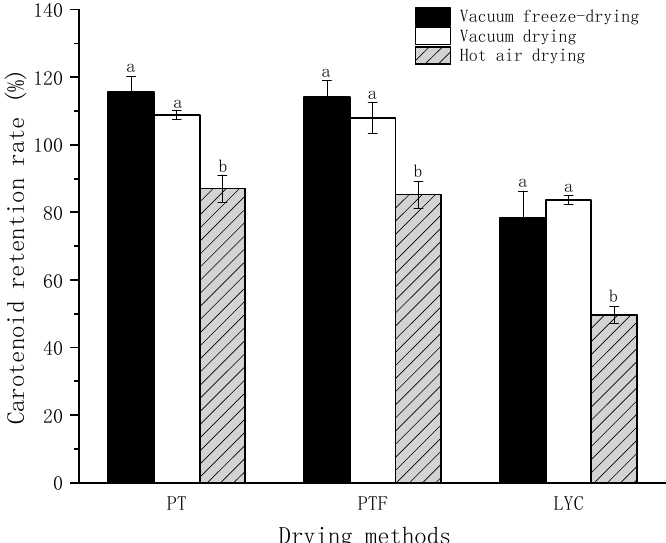
Figure 3. The retention rates of PT, PTF and LYC in different drying methods. The raw material was the mixed tomato pulp of five tomato varieties selected. The water content terminal point 5 ± 2%. The retention rate was obtained by comparing tomato powder with tomato pulp material. Different letters of the same carotene indicate significant differences, according to Duncan test ( p < 0.05).